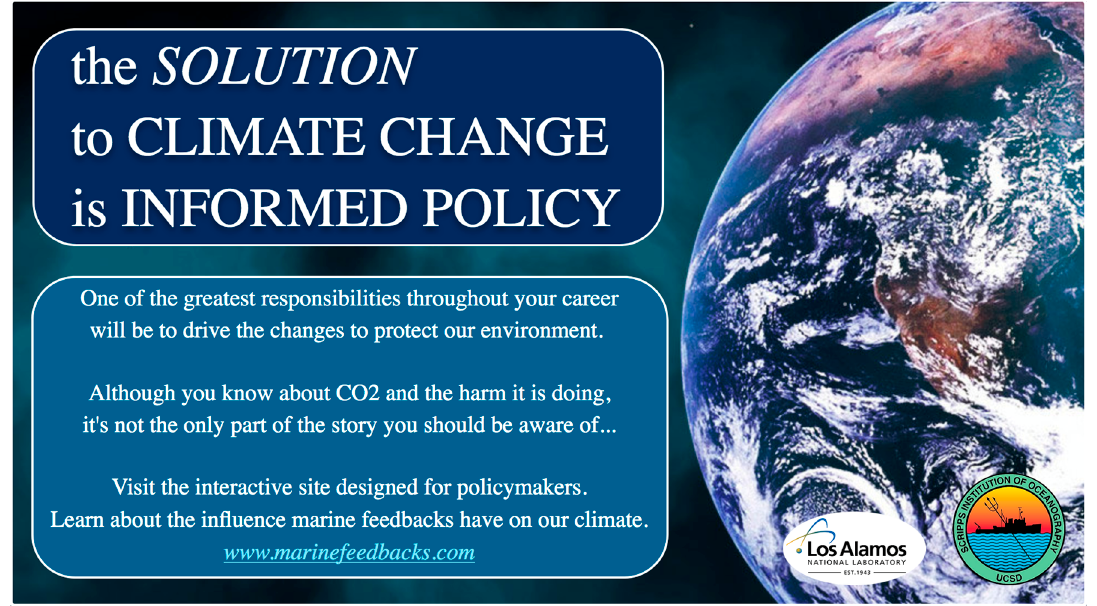
Figure 4. The advertisement used to promote the website on Facebook.com.